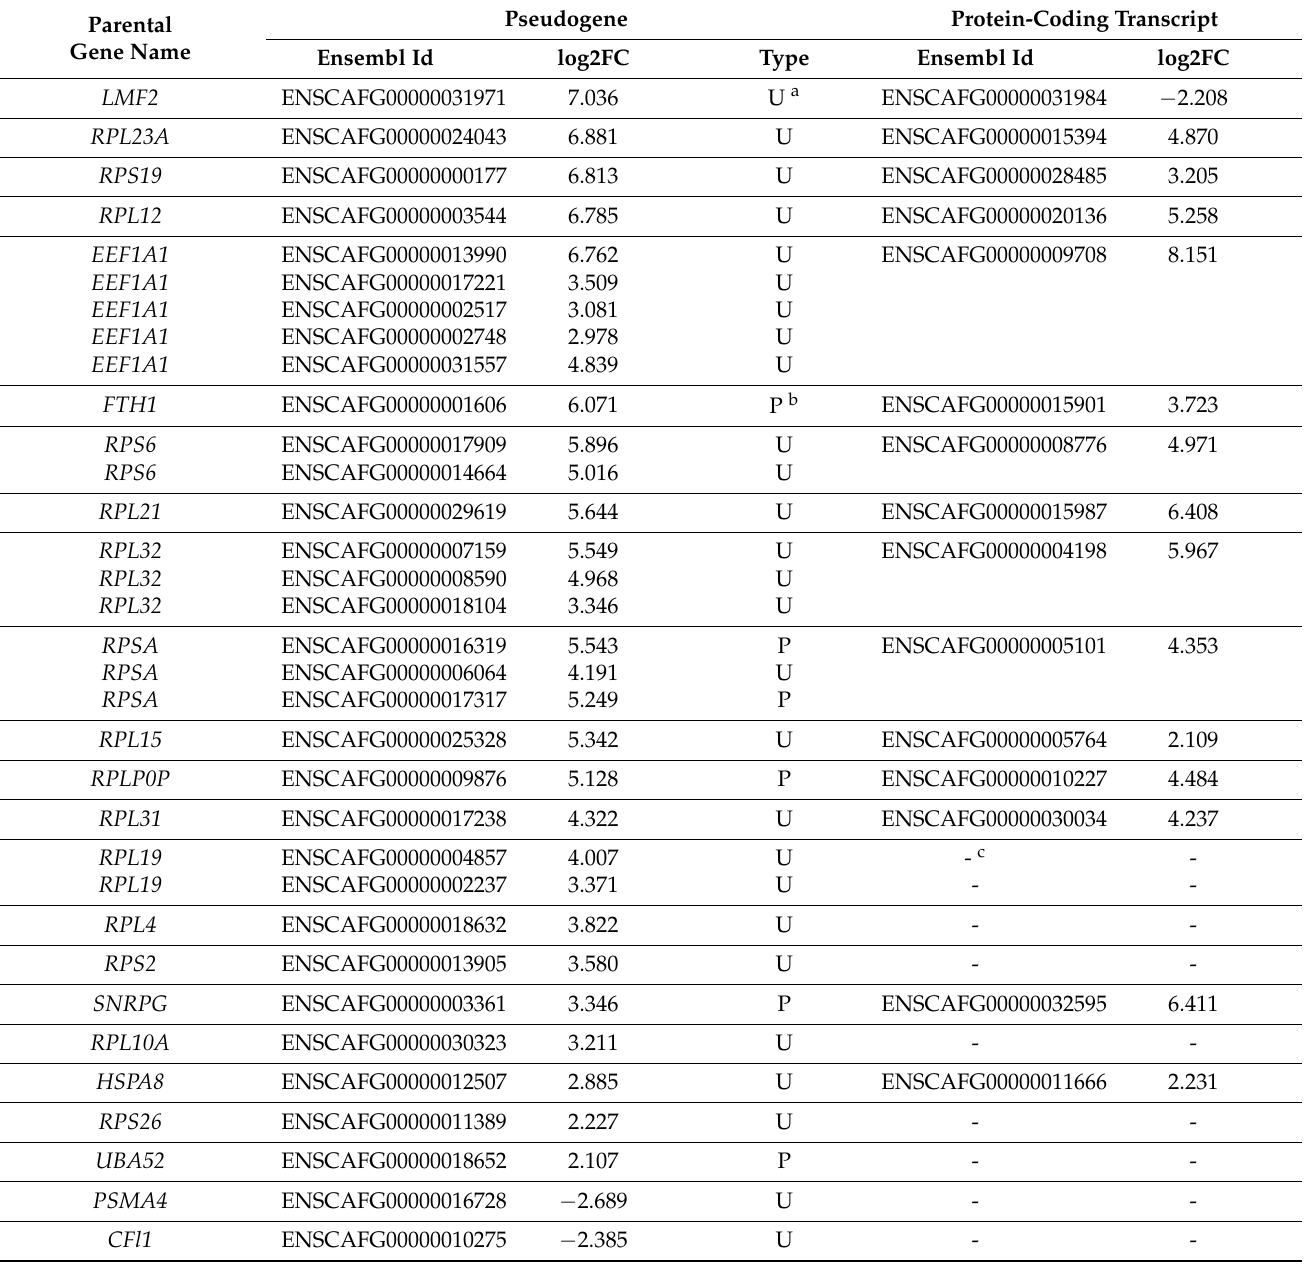
Table 3. Differently expressed pseudogenes matched with their respective parental